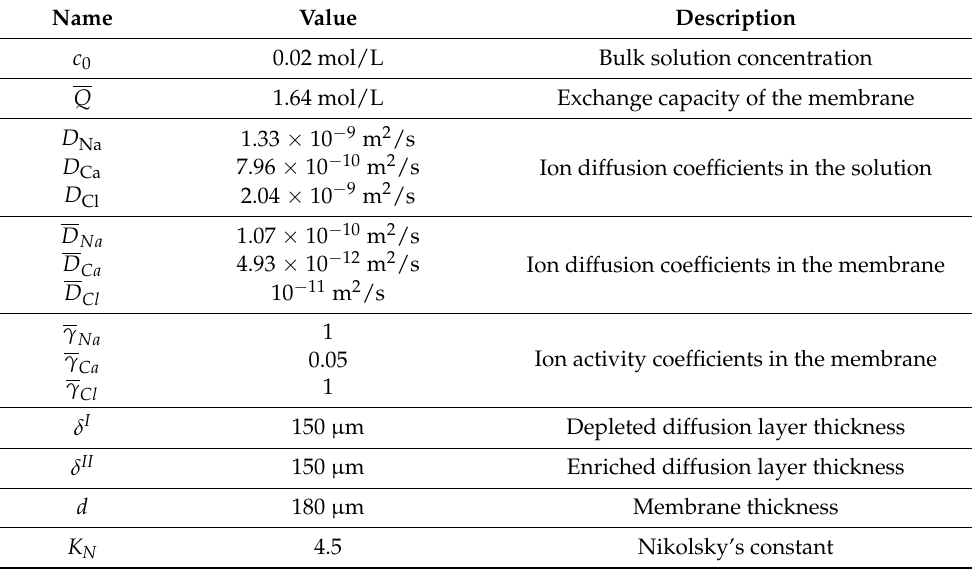
Table 2. Input parameters used in the